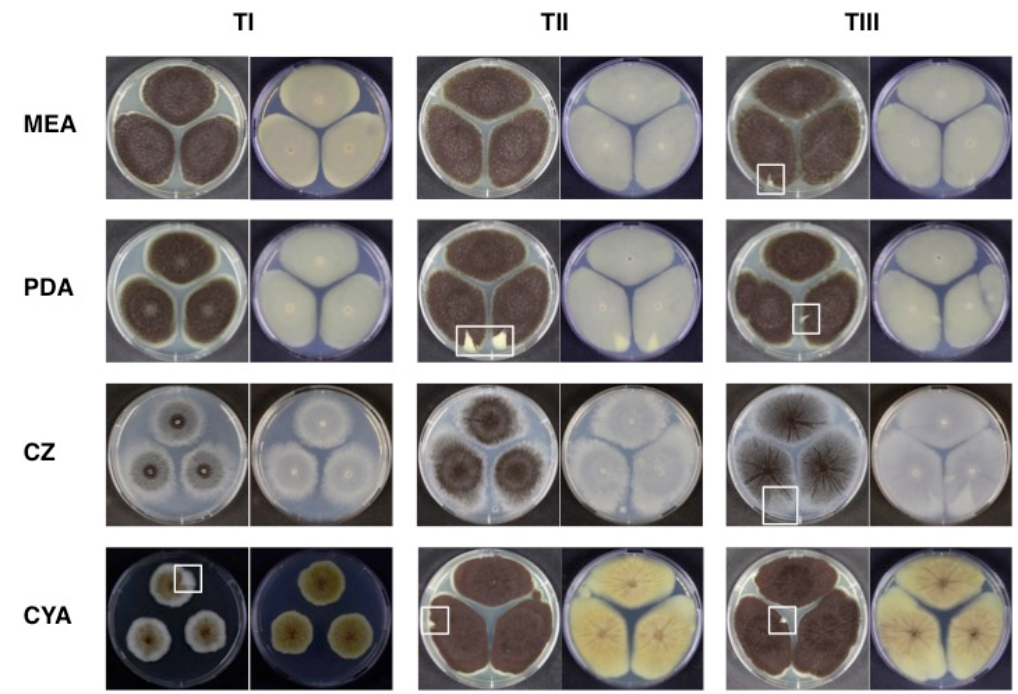
Figure 2. Morphological characteristics of Aspergillus aculeatus MUM 03.11 before (Time I), after 2 weeks (Time II) and 4 weeks (Time III) of freeze-drying and accelerated storage. Obverse (left) and reverse (right) of colonies grown for 7 days in the dark, at 25 ◦ C on MEA, PDA, CZ and CYA media. Sectorisation areas are indicated by white boxes. Table 2. Percentage of phenotypical sectorisation observed of Aspergillus strains grown in four di ff erent media after 7 days in the dark, at 25 ◦ C, for di ff erent preservation time points (before (Time I), after 2 weeks (Time II) and 4 weeks (Time III) of